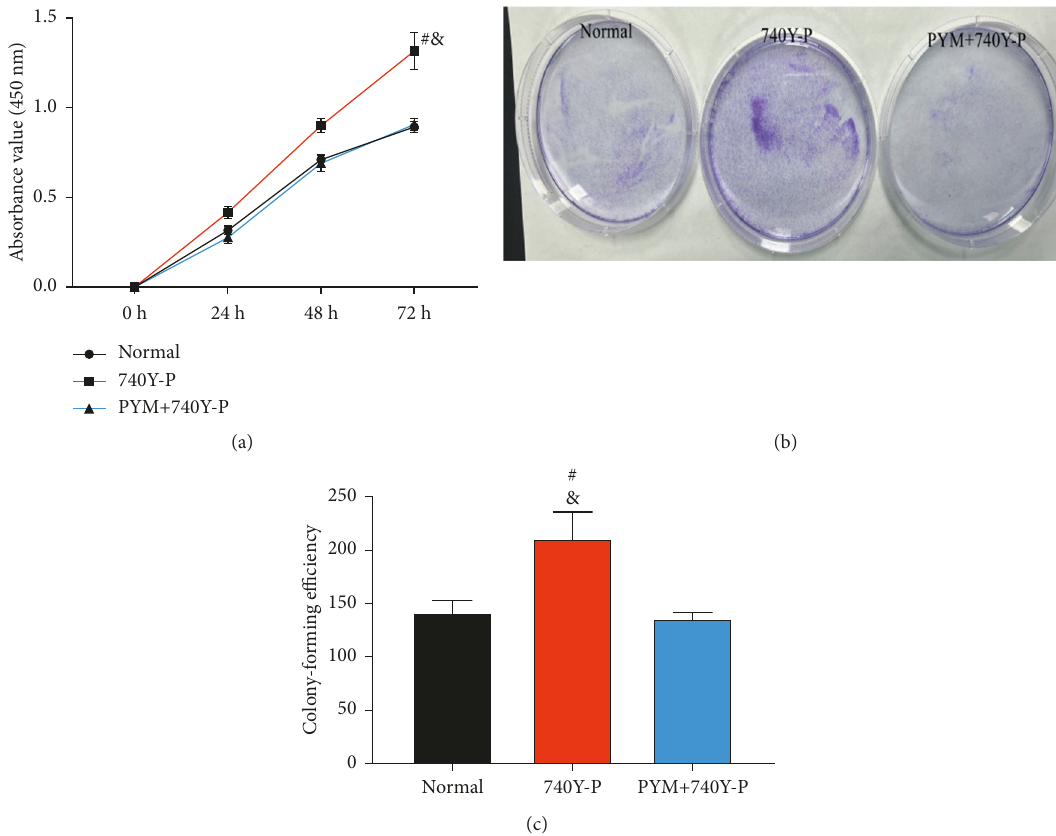
Figure 5: PYM influences OC cell apoptosis via PI3K/AKT/mTOR axis. (a) Cell growth curve. (b) Experimental results of colony formation assay. (c) Colony-forming efficiency. Compared with the normal group, # P